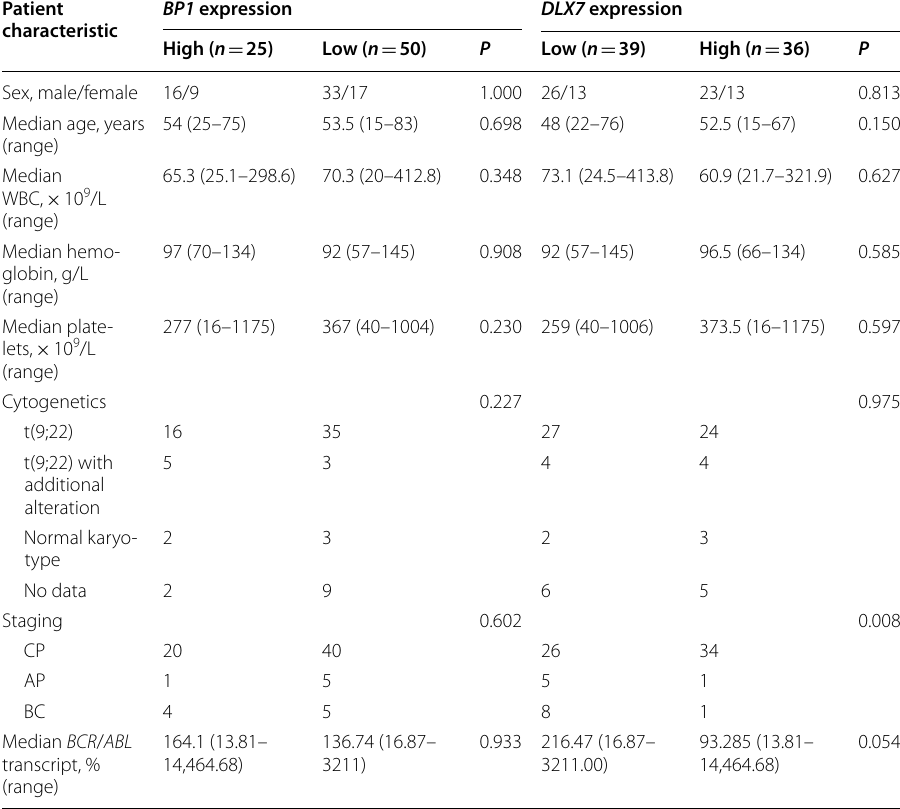
WBC, white blood cells; CP, chronic phase; AP, accelerated phase; BC, blast crisis